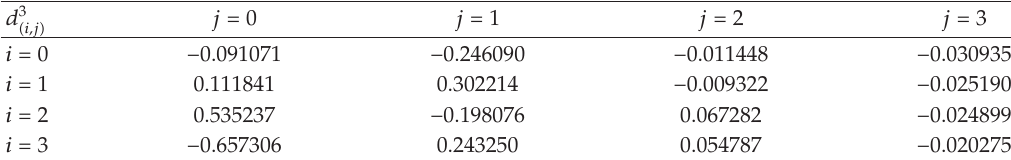
Table 4: The coe ffi cients of a high-pass wavelet filter (cid:3) d 3 (cid:3) i,j (cid:4) (cid:4) associated with the low-pass wavelet filter in Table